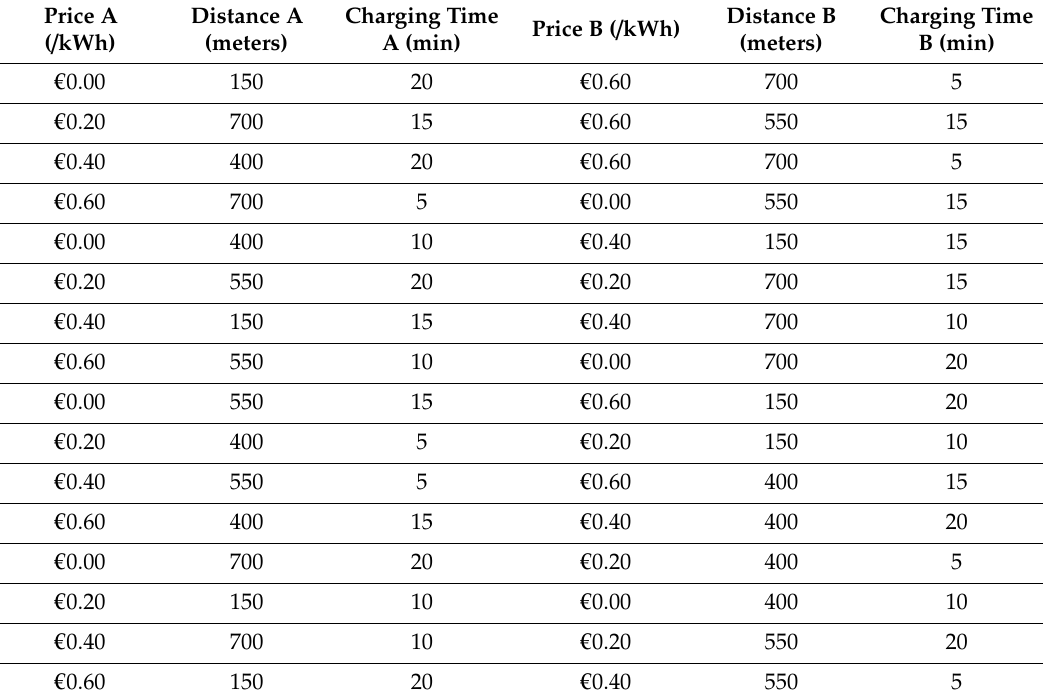
Table A1. Parameters for fast charging stations are displayed. The parameters for the slower charging stations were kept